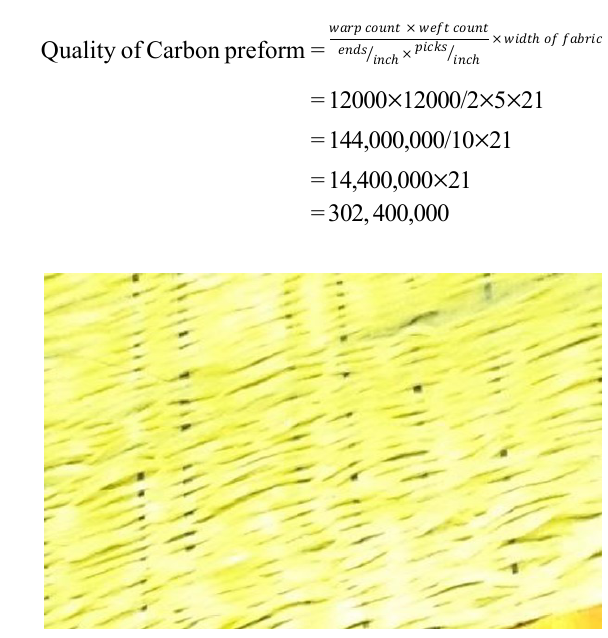
FIGURE 20 CARBON PREFORM PLAIN WEAVE